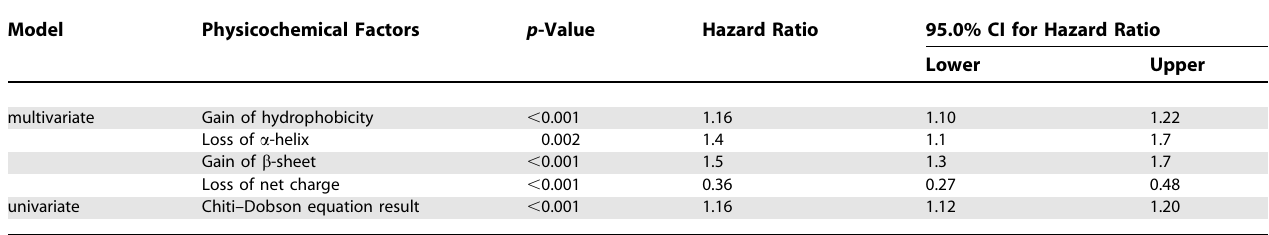
Table 3. SOD1 Variants’ Gain of Hydrophobicity, Loss of a -Helix, and Gain of b -Sheet Propensity Are ALS Risk Factors, While Loss of Net Charge Is Protective